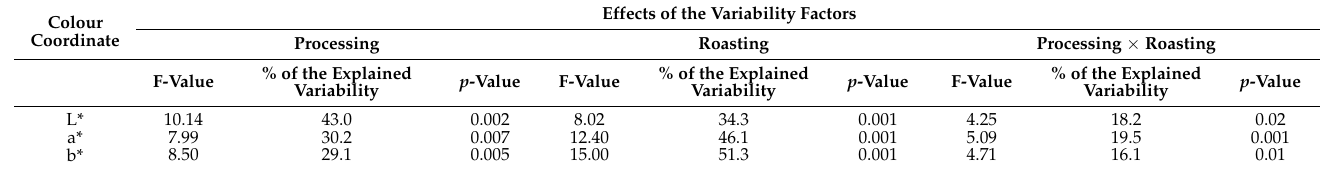
Table 4. Effect of the processing method and the degree of roasting, respectively, on L*, a*, and b* coordinates in the coffee samples processed by either wet or dry method and, consequently, roasted to the three different degrees. L* represents lightness (100 for white and 0 for black), chromatic coordinates a* and b* represent the colour space between red (+a*) and green ( − a*), and between yellow (+b*) and blue ( − b*), respectively; two-factor ANOVA with interaction; n =